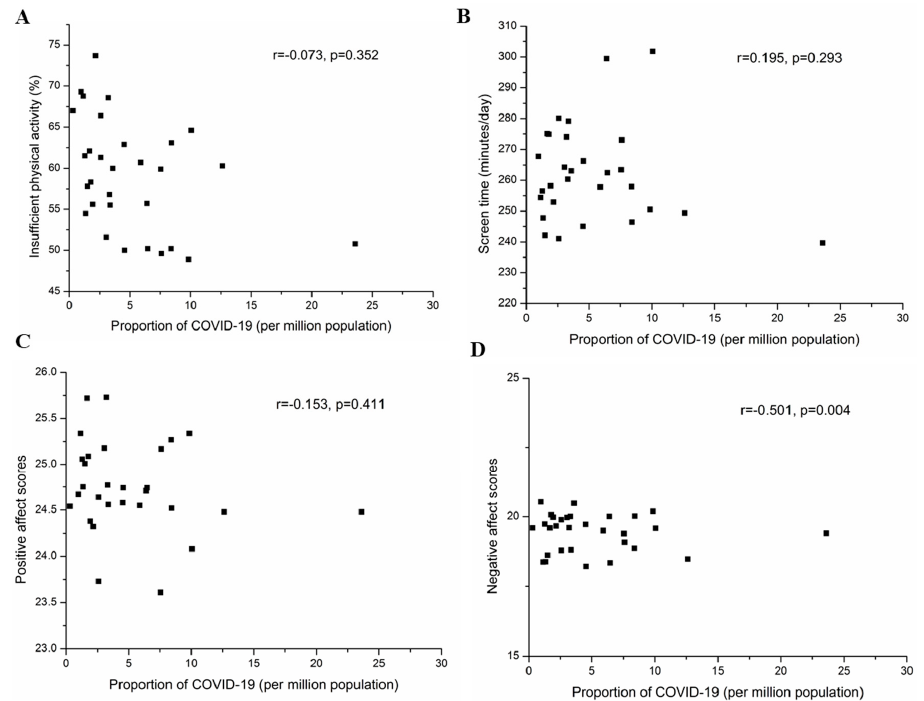
Figure 4. Scatterplots showing correlations between provincial levels of lifestyle and emotional